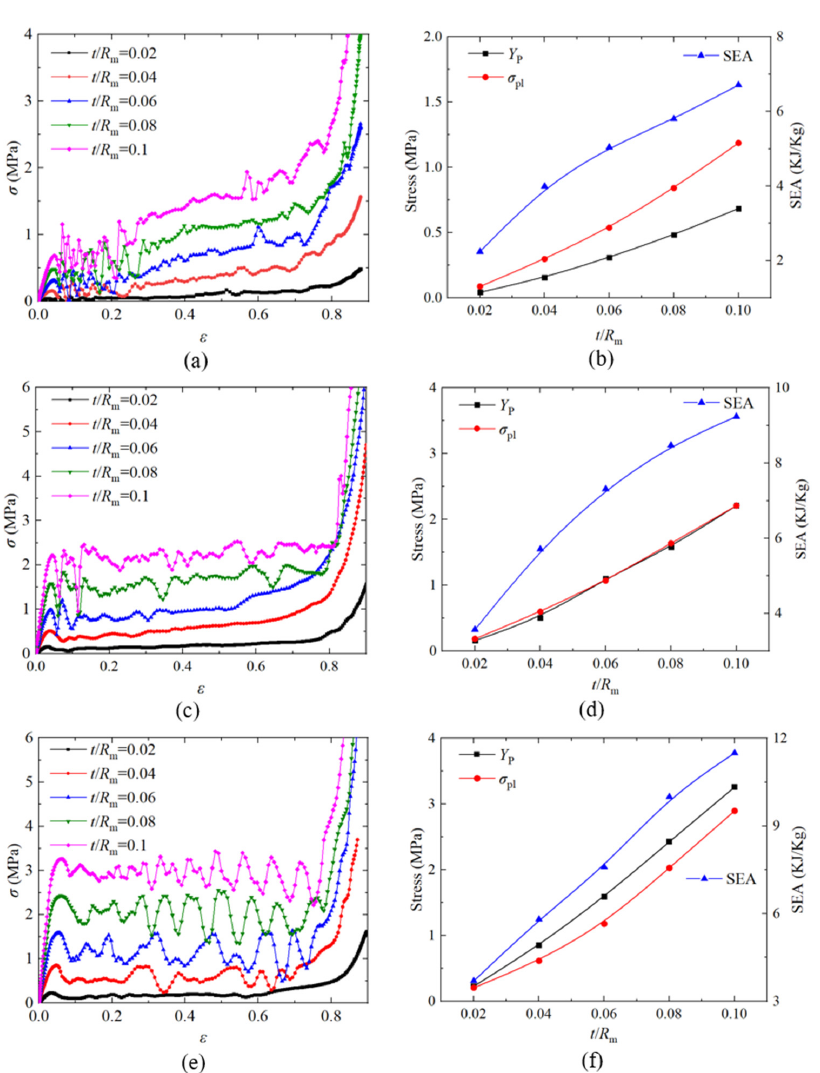
0.1. Figure 9a,c,e shows the nominal stress–strain curves of the SC, BCC, and FCC PHSSs, respectively, with different wall thicknesses under quasi-static compression; Figure 9b,d,f shows the curves describing the variations in first peak stress Y P , plateau stress σ pl , and SEA with different wall thicknesses for the SC, BCC, and FCC PHSSs, respectively. The results indicate that the Y P , σ pl and SEA values of the different PHSSs increased as the wall thickness increased, and the differences were as follows: for the SC PHSS, Y P was always less than σ pl ; for the BCC PHSS, Y P was essentially equal to σ pl ; and for the FCC PHSS, Y P was always greater than σ pl .